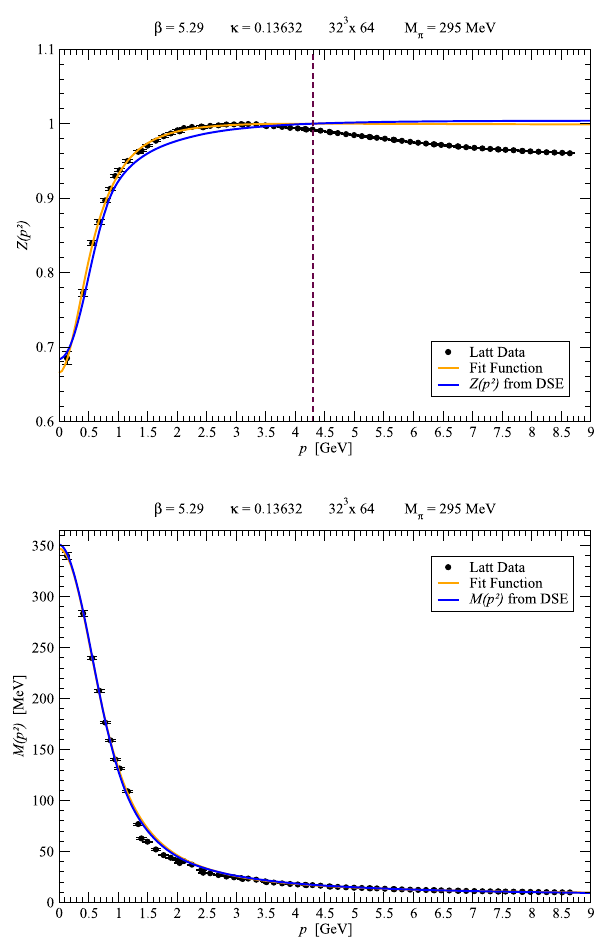
Fig. 3 The quark wave function and the running quark mass as given by the r.h.s. of the Schwinger–Dyson equations for our vertex solution, compared with the fit functions that parametrise Z ( p 2 ) and M ( p 2 ) and the lattice data for the quark propagator. For comparison the quark wave function was renormalised in the MOM-scheme at μ = 4 . 3 GeV. The lattice data from N f = 2 full QCD simulation in the Landau gauge [18,22] for β = 5 . 29, κ = 0 . 13632 and for a 32 3 × 64 lattice was rescaled using the parameterisation reported in Appendix A. See [4] for the discussion on the parameterisation of the lattice quark propagator